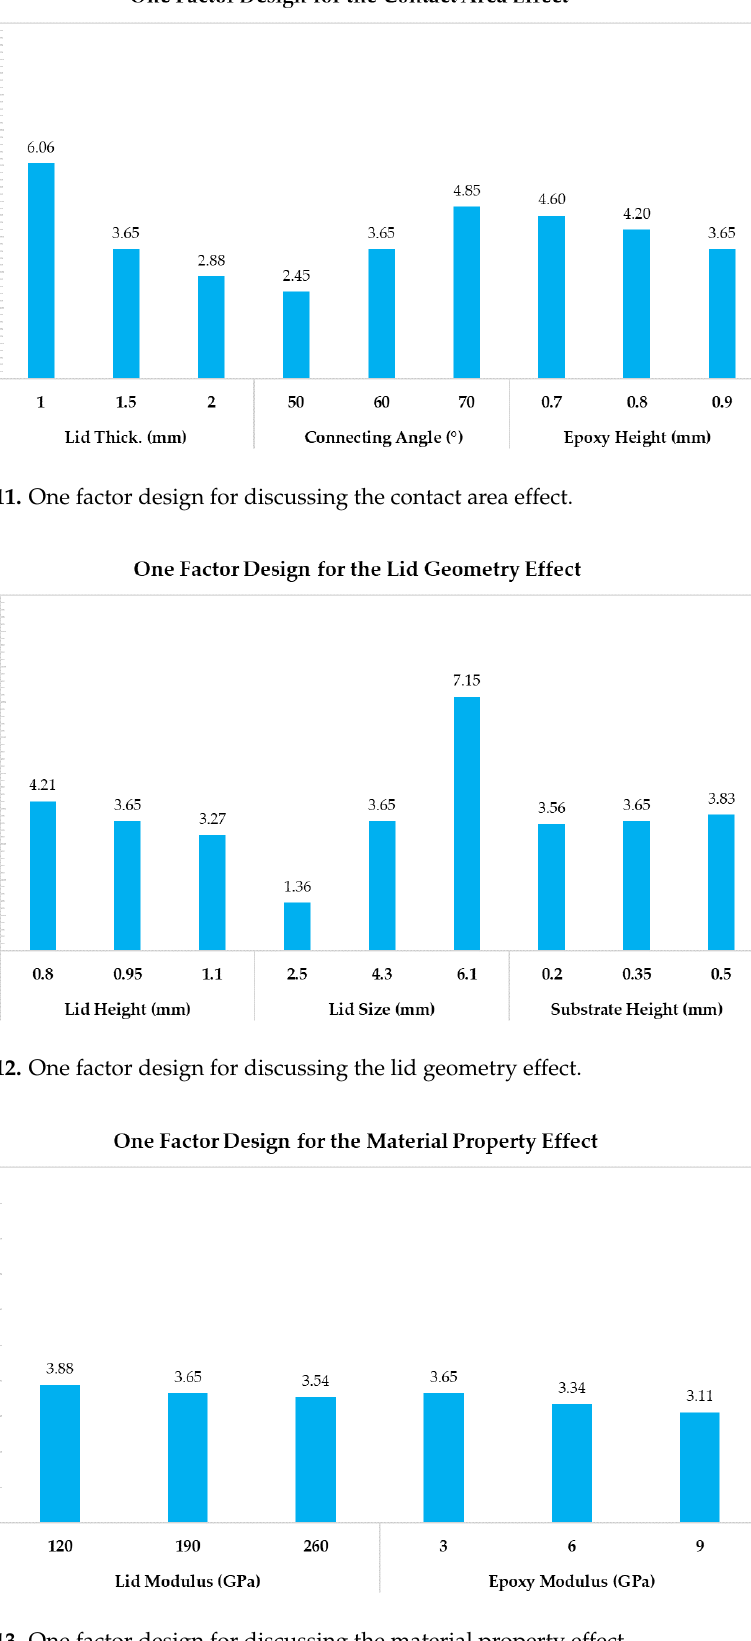
Figure 13. One factor design for discussing the material property effect.